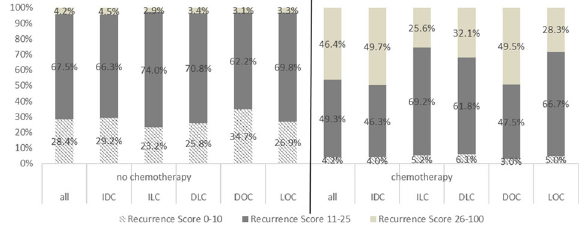
Fig. 3 Association of adjuvant chemotherapy use with RS. Association of adjuvant chemotherapy use with low (0 – 10), intermediate (11 – 25, and high (26 – 100) RS for entire patient cohort (no chemotherapy: n = 54,240; chemotherapy: n = 19,198) and for each histologic subtype. (IDC: no chemotherapy: n = 41,069; chemotherapy: n = 15,773; ILC: no chemotherapy: n = 6880;